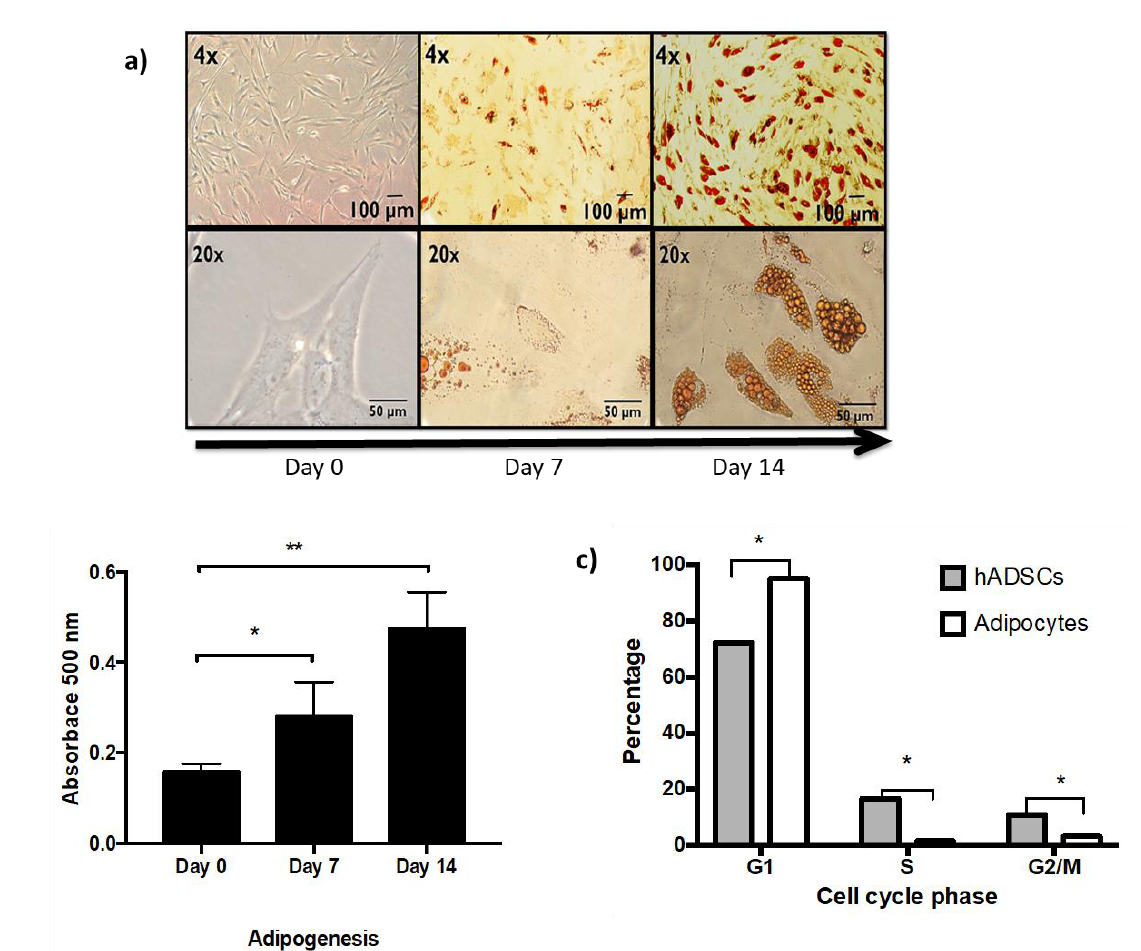
Figure 1. In vitro adipogenesis from hASCs. ( a ) Representative light microscopy images showing Oil Red O staining to identify lipid vesicles acquired through differentiation (day 0, 7, and 14). 4× and 20× magnification of the same fields. ( b ) Spectrophotometric quantification at 500 nm of the Oil Red O staining performed through adipogenesis in three independent experiments, Student’s t test vs control * p < 0.05, ** p < 0.01. ( c ) Post-mitotic arrest of adipocytes. Percentage of cells in the different stages of the cell cycle, comparing hASCs and 14-day adipocytes. Three independent experiments with experimental replicate were carried out. One way ANOVA test, * p < 0.05.